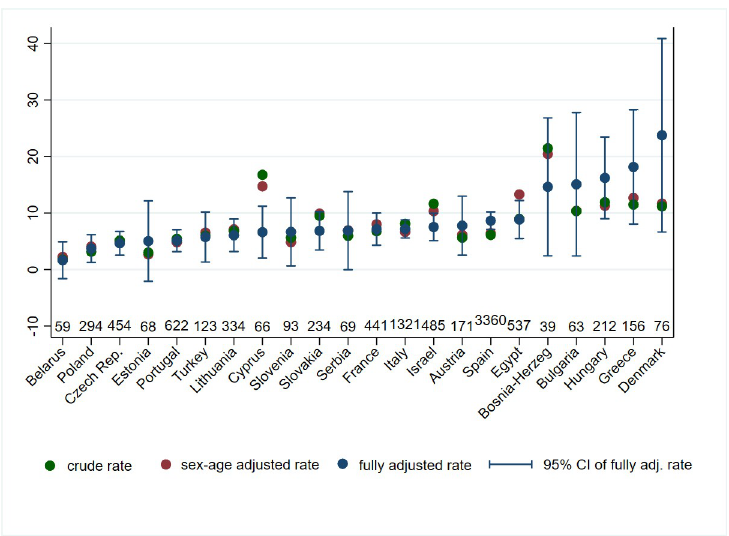
Fig 2. Crude mortality rates and adjusted mortality rates with 95% CI (vertical blue lines), by country sorted by lowest to highest adjusted rate.